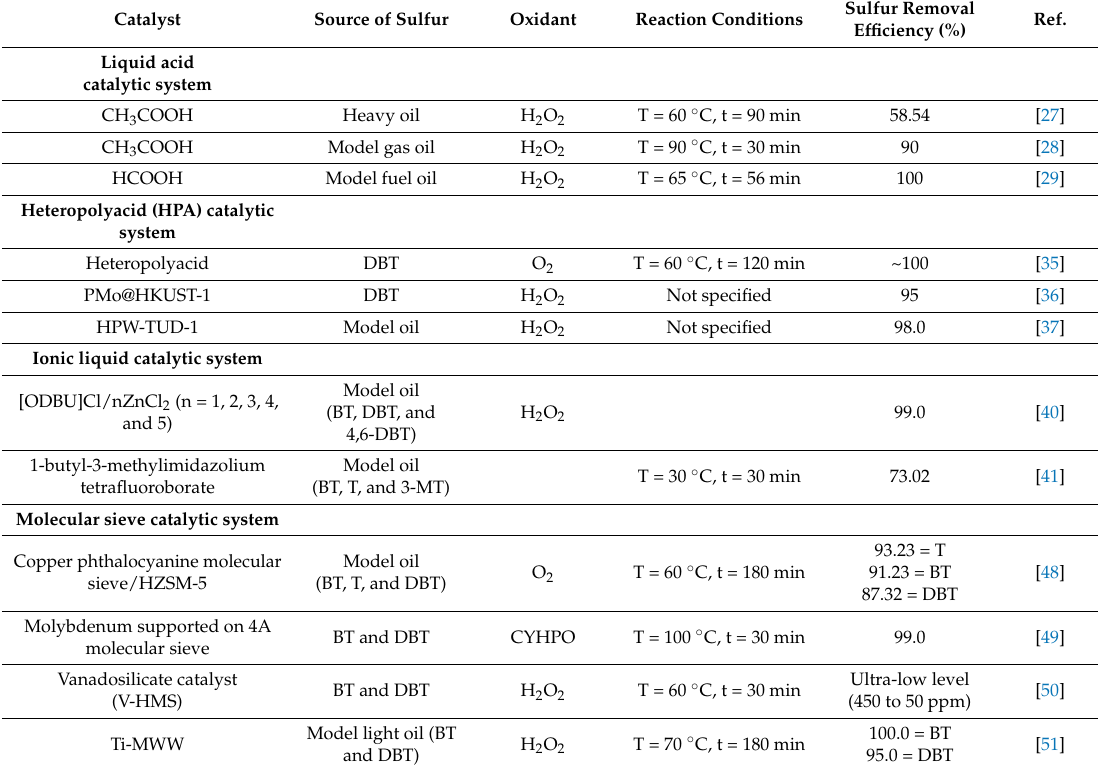
Table 1. Summary table for oxidative catalytic desulfurization of liquid fuel oil.